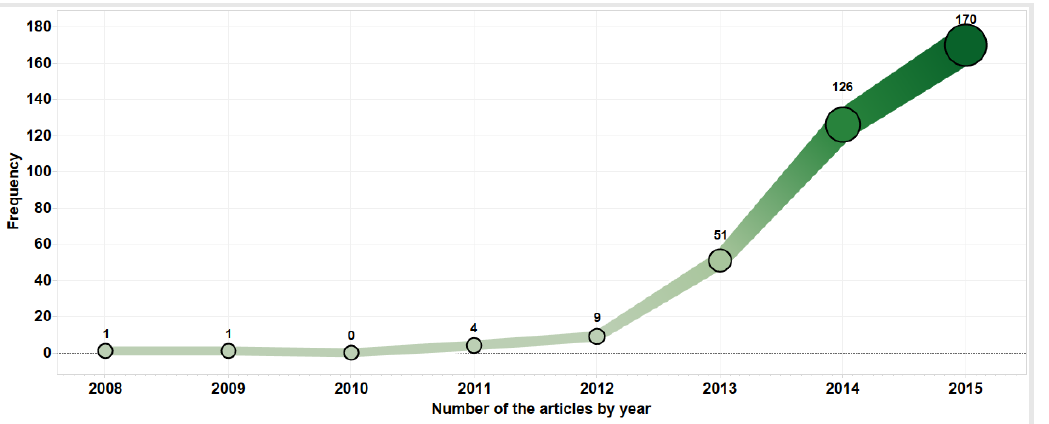
Figure 1 . Frequency of the sampled articles by